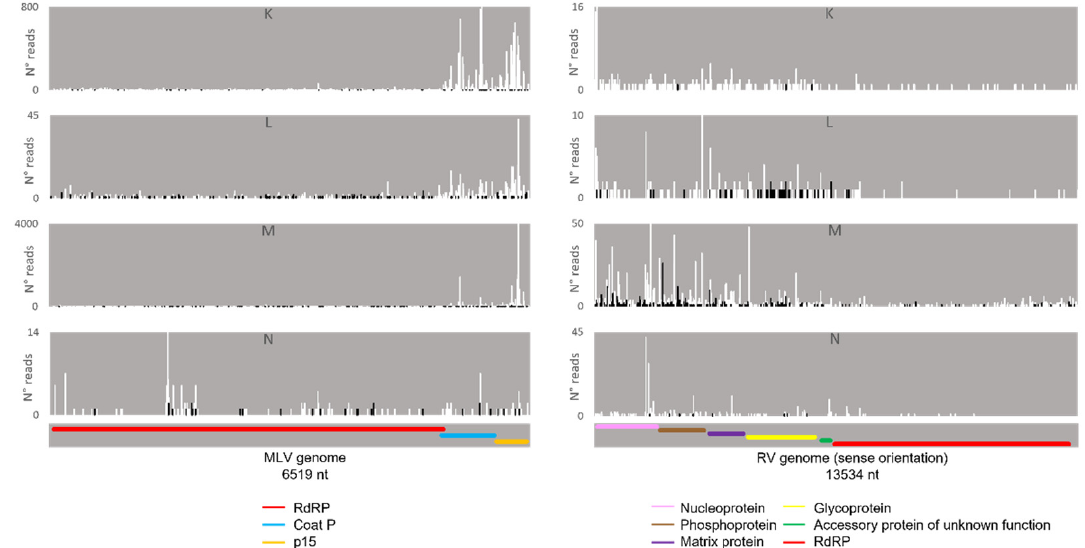
Figure 15. Distribution of 26–29 nt-long sRNAs bound to BmN4 Ago3, mapping to B. mori Macula- like Latent Virus (MLV) ( left ) and S. frugiperda Rhabdovirus (RV) ( right ). White bars: sense reads. Black bars: anti-sense reads. K–N: represented databases, listed in Table S2. Red: RdRp ORF; blue: coat P ORF; orange: p15 ORF; pink: nucleoprotein ORF; brown: phosphoprotein ORF; purple: matrix protein ORF; yellow: glycoprotein ORF; green: accessory protein of unknown function ORF.